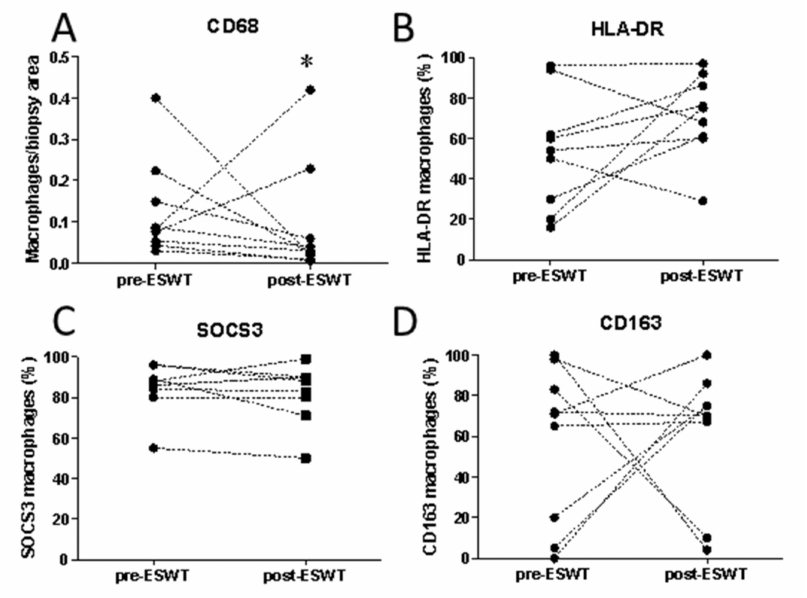
Figure 3. Extracorporeal shock wave therapy (ESWT) alters the number and activation of macrophages in wound biopsies. The number ( A ) and activation status of macrophages ( B – D ) was determined by immunohistochemistry in patient biopsies before and after ESWT. Macrophage activation markers were defined as ( B ) HLA DR and ( C ) SOCS3 for M1 activated macrophages and ( D ) CD163 for M2 activated macrophages. * represents differences between values before and after ESWT treatment, p <